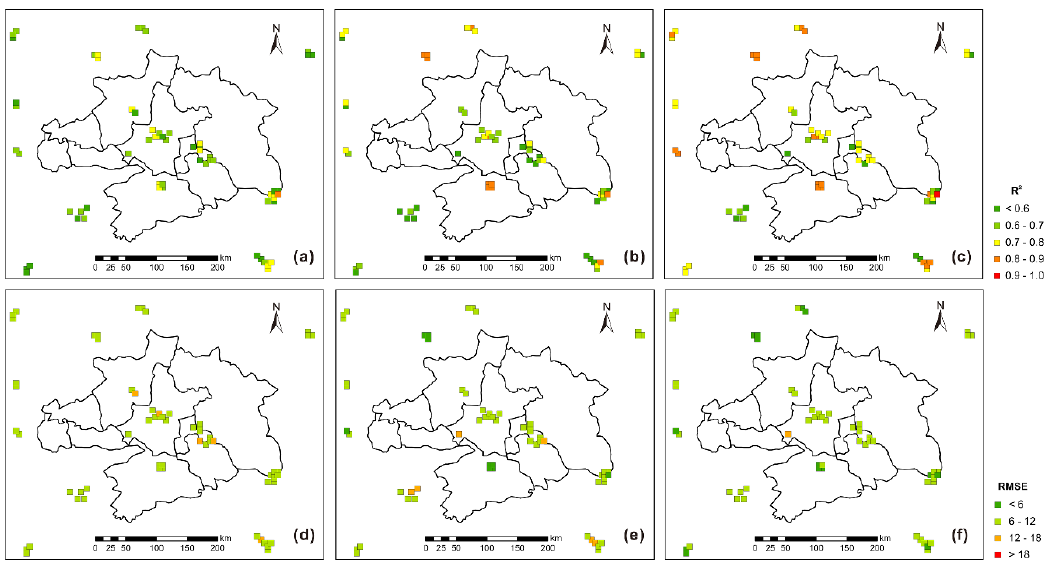
Figure 5. Site-based CV performance for each grid cell. ( a – c ) are R 2 distributions for the GTWR, global GRNN, and GTW-GRNN models, respectively. ( d – f ) are RMSE distributions for the GTWR, global GRNN, and GTW-GRNN models, respectively.